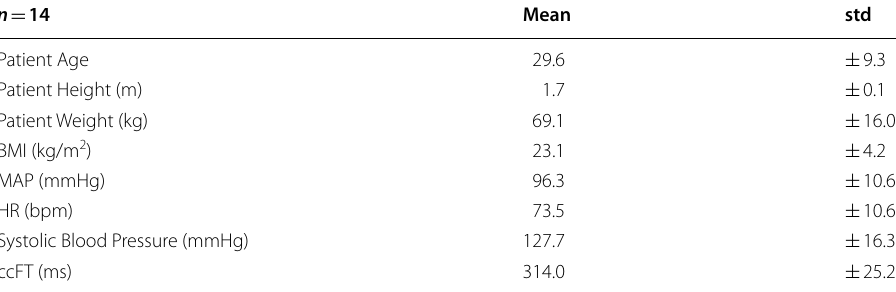
M is meters, kg/m 2 is kilograms per meters-squared, mmHg is millimeters of mercury, bpm is beats per minute, ccFT is corrected flow time of the carotid artery, ms is milliseconds